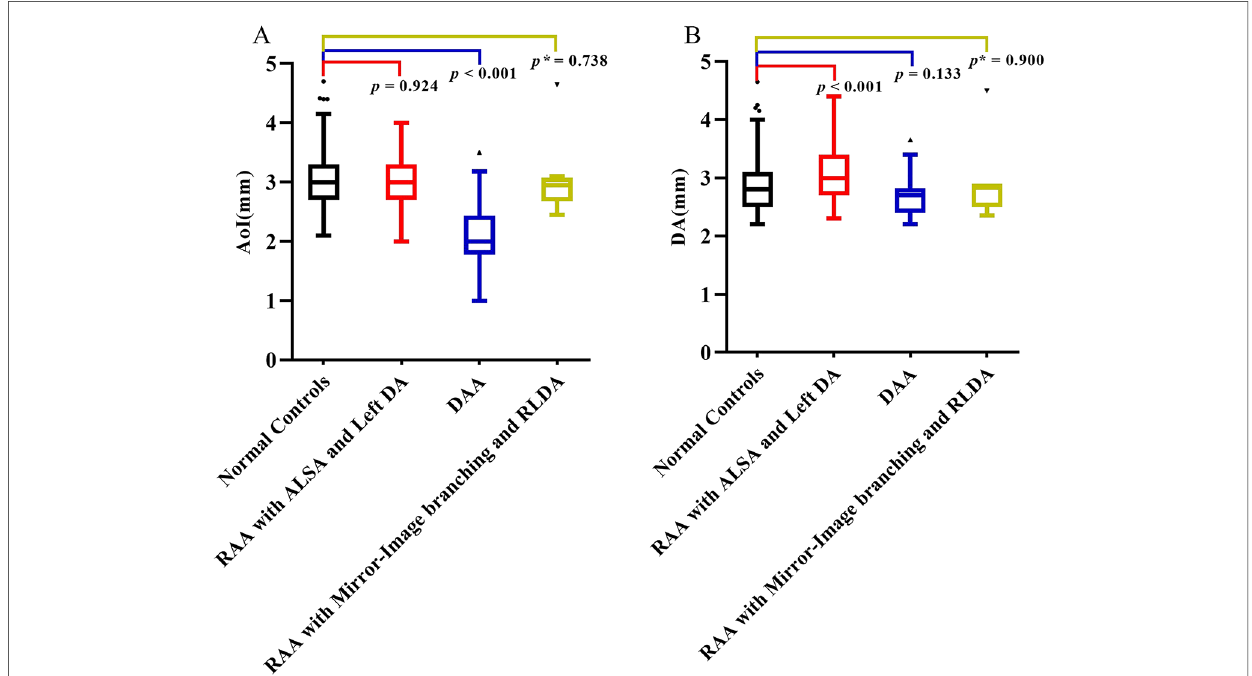
FIGURE 4 ( A,B ) Comparison of AoI and DA diameters measured by fetal MRI. ( A ) Box-graph showed the differences of the diameters of AoI between the normal controls group and three subgroups of CVR; ( B ) box-graph showed the differences of diameters of DA between normal controls group and three subgroups of CVR. p <0.05 was considered statistically signi fi cant. p refers for independent sample t -test, and p * refers for Mann-Whitney U -test. AoI, aortic arch isthmus; DA, ductus arteriosus; RAA with ALSA and left DA, right aortic arch with aberrant left subclavian artery and left ductus arteriosus; DAA, double aortic arch; RAA with mirror-image branching and RLDA, RAA with mirror-image branching and retroesophageal left ductus arteriosus.